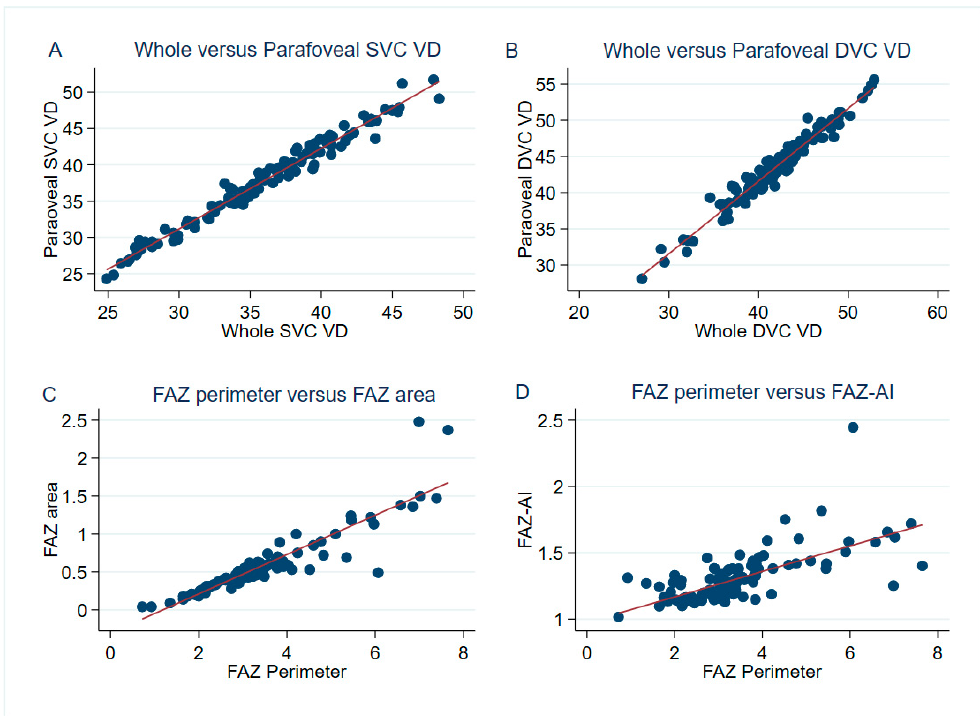
Figure 2. Representative pairs of optical coherence tomography angiography parameters with a significant correlation in the 3 × 3 mm scan area. The whole image superficial vascular complex (SVC) vessel density (VD) had an excellent correlation with the parafoveal SVC VD ( r = 0.99, p < 0.001) ( A ). A very strong correlation was also found between the whole image deep vascular complex (DVC) VD and the parafoveal DVC VD ( r = 0.98, p < 0.001) ( B ). There was a strong correlation between the foveal avascular zone (FAZ) perimeter and the FAZ area ( r = 0.90, p < 0.01) ( C ), while the FAZ perimeter was positively correlated to the FAZ acircularity index (FAZ–AI) ( r = 0.68, p < 0.001) ( D ). Table 1. Baseline systemic and ocular characteristics.